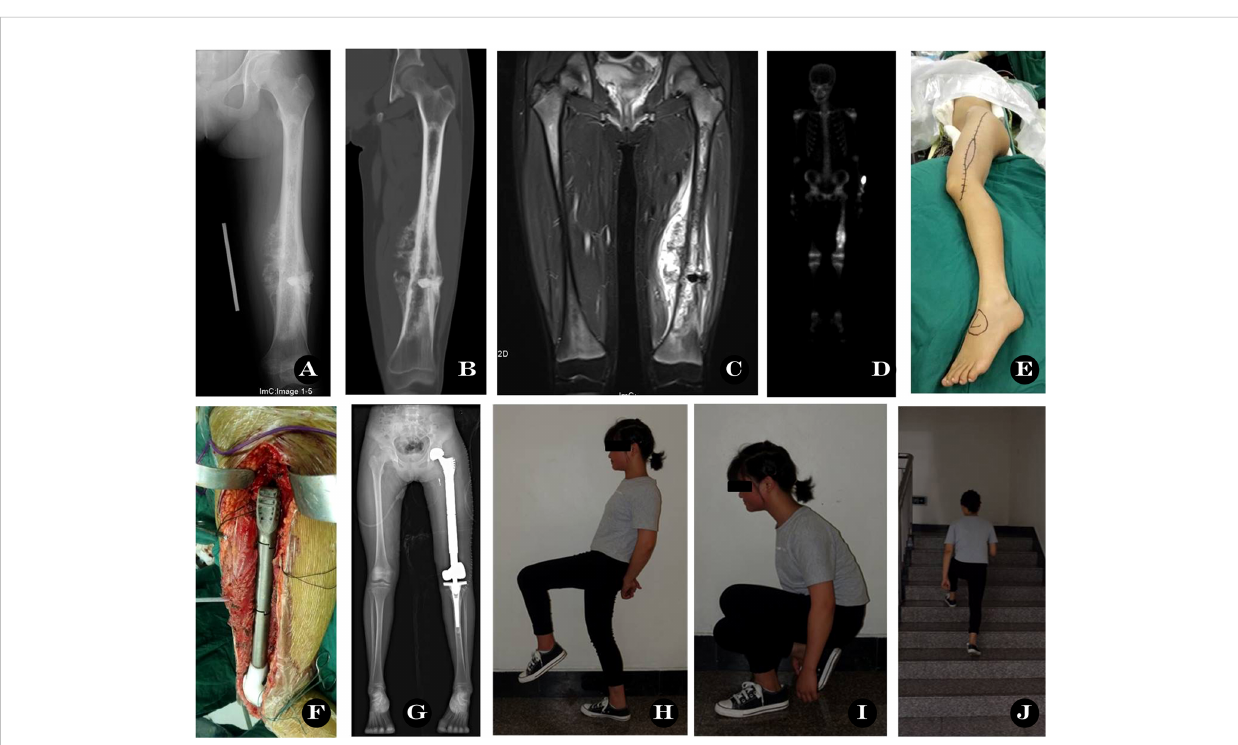
FIGURE 1 Total femoral prosthesis replacement. A 15-year old girl with left femur osteosarcoma. (A) X-ray before operation, (B – D) CT, MRI and SPECT image showing massive involvement, (E) Surgical incision, (F) Total femur prosthesis in operation, (G) X-ray post-operation, (H – J) Functional outcome at 33